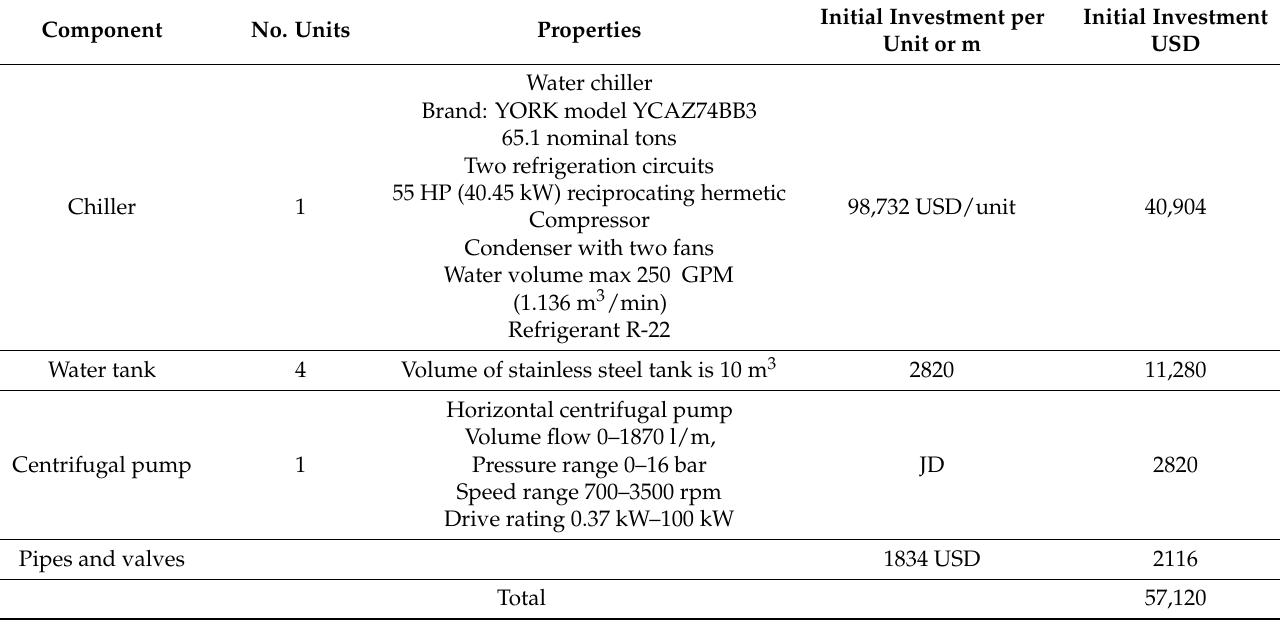
Table 2. Components and its capital investment for the chilled water